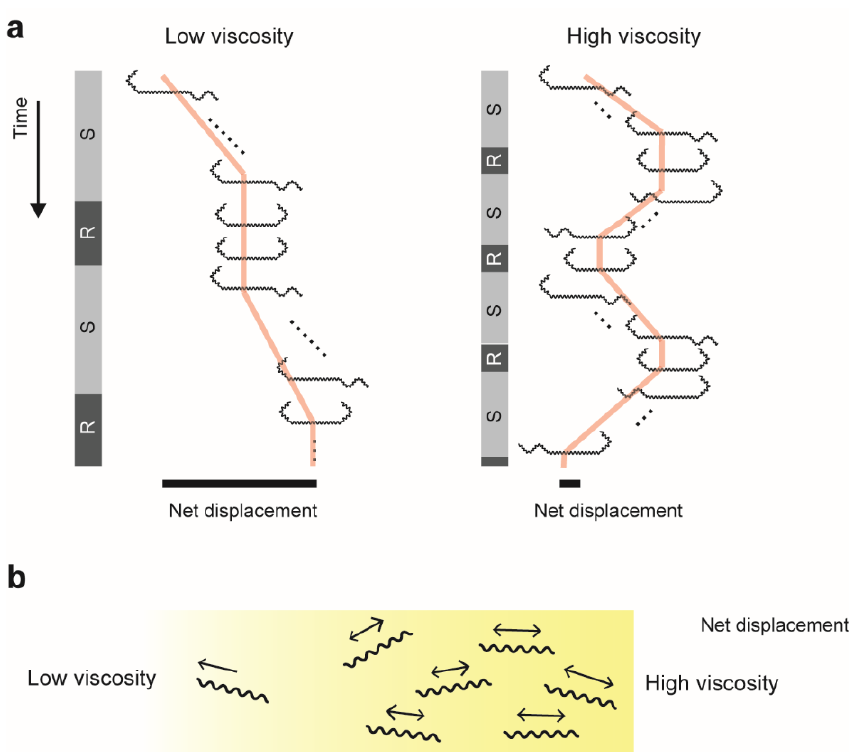
Figure 2. Enhancement of swimming reversal in high viscosity: ( a ) Schematic explanations of transition between swimming (S) and rotation (R) modes. For simplicity, the rotation mode indicates only Hook – Hook morphology. Time courses of cell positions show the effect of reversal on net displacement (black bars). ( b ) Accumulation of bacteria in high viscosity due to limitation of net migration. See [16] for more details.